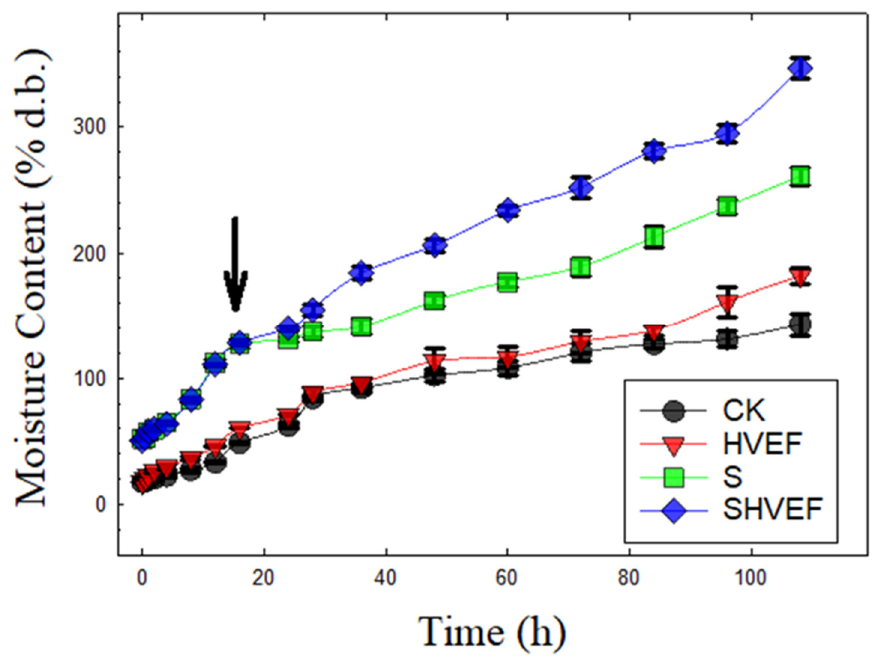
Figure 4. Water absorptions of control seed (CK); soaking-treated seed (S); high-voltage electric field-treated seed (HVEF); soaking + high-voltage electric field-treated seed (SHVEF).